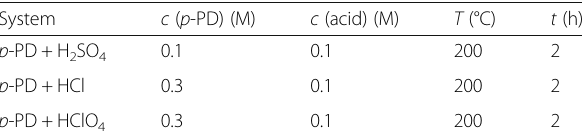
Table 1 The selected experimental parameters of p -PD + acids systems